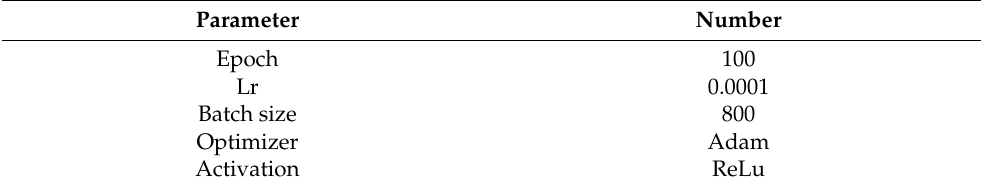
Table 5. The parameters of the LSTM network.